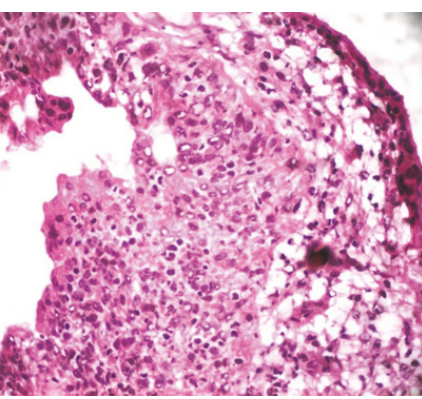
Figure 1: Intraoperative frozen section: atypical cells that were suggestive of ovarian borderline or malignant epithelial